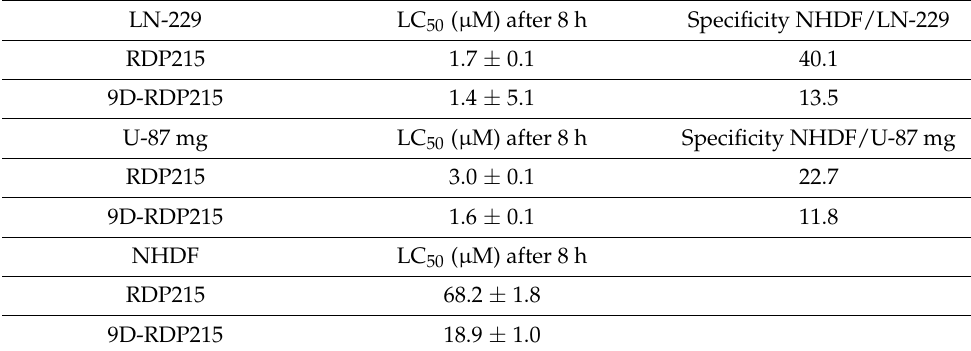
Table 6. A comparison of LC 50 values (µM) of cell lines LN-229 glioblastoma and normal human dermal fibroblasts NHDF determined by PI-uptake upon 8 h of peptide treatment.